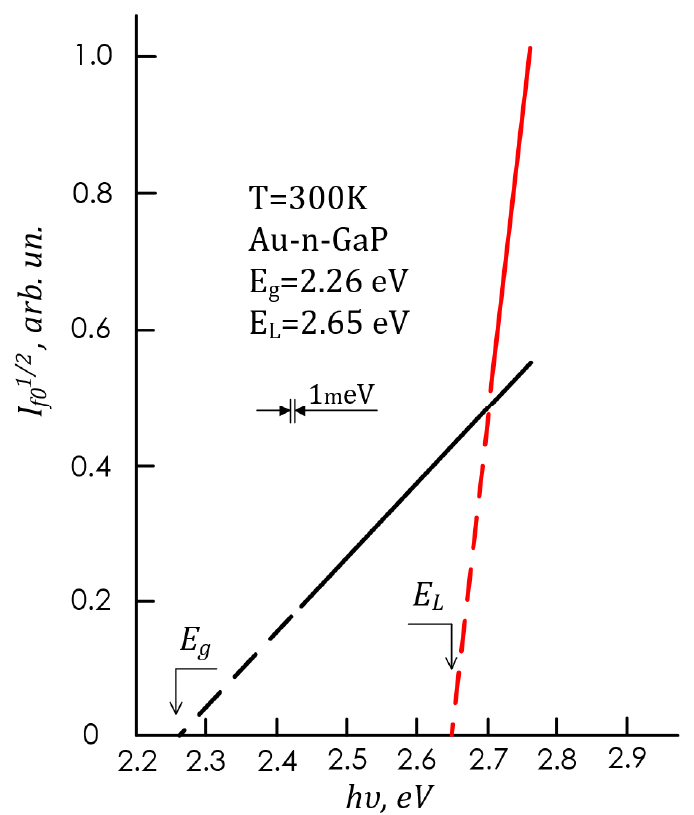
Figure 7. Dependence of the photocurrent I f01/2 related to an equality of incident photons on the h ν for four Au-Pd-n-GaP surface-barrier structures (Sample No. 4, β = 1.19).